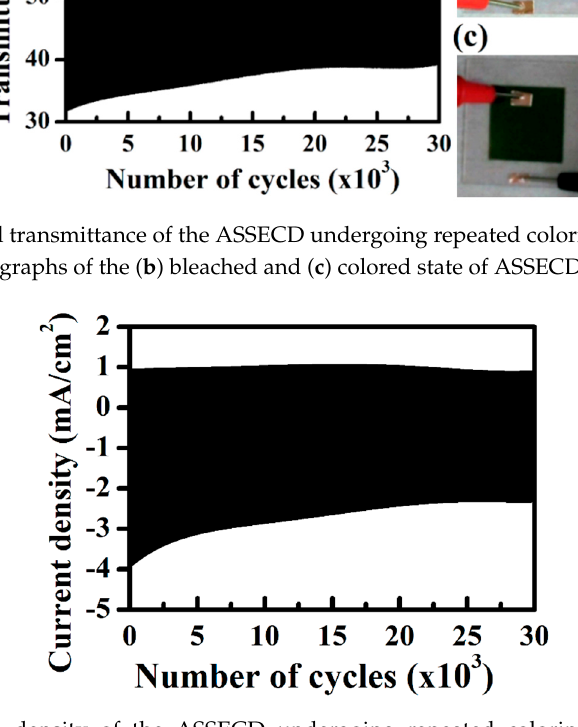
Figure 15. Current density of the ASSECD undergoing repeated coloring and bleaching for 3 × 10 4 cycles.